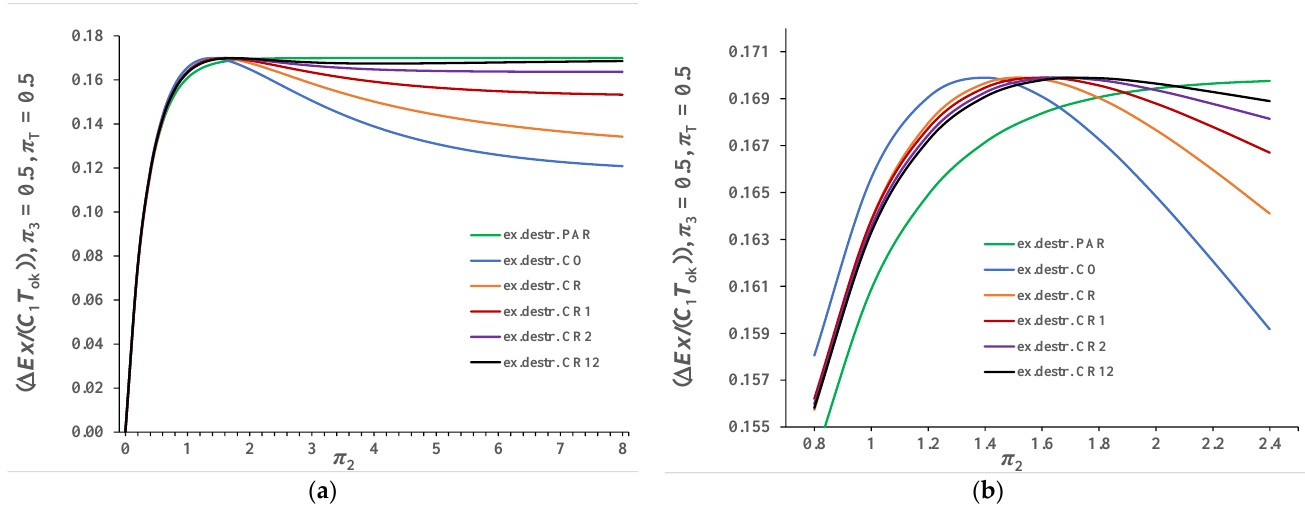
Figure 9. Dependence of exergy destruction on π 2 for π T = 0.50 and π 3 = 0.50: ( a ) 0 < π 2 < 8.0; ( b ) 0.8 < π 2 < 2.3.